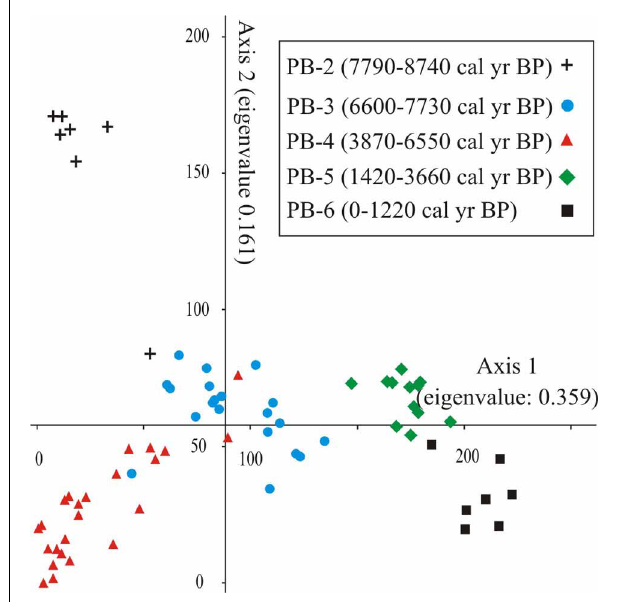
FIGURE 4 | Ordiantion results of Axes 1 and 2 of the DCA of Holocene-aged pollen samples (8740-0 cal. year BP) from Paul’s Bog core. Groups were labeled by time